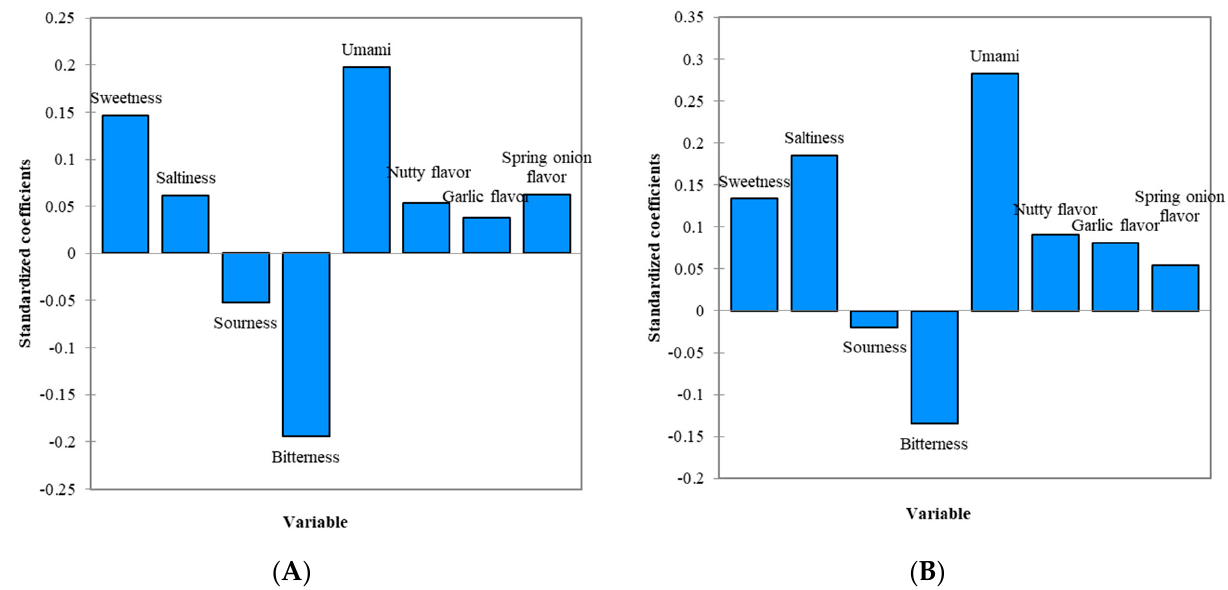
Figure 2. ( A ) Standardized coefficients from the PLS regression for soft tofu stew sauce with 0.40% salt in the absence of MSG. ( B ) Standardized coefficients from the PLS regression for soft tofu stew sauce with 0.28% salt in the presence of 0.16% MSG.